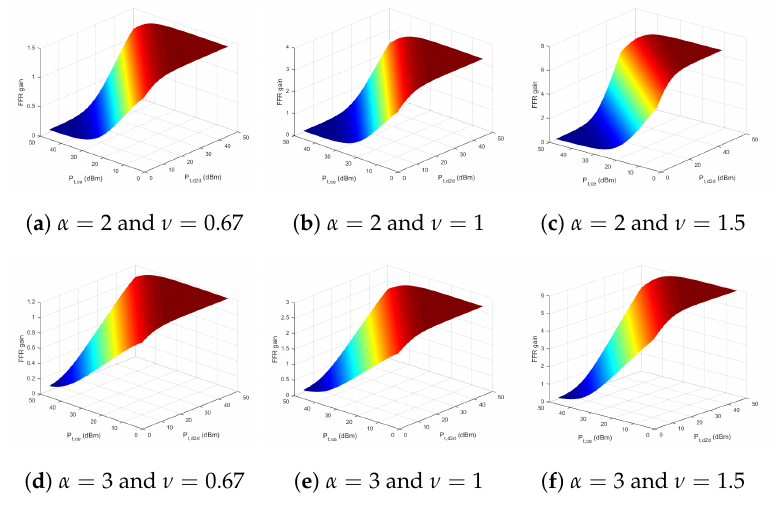
Figure 11. FFRgain versus P t , CE and P t , D 2 D with various α and ν